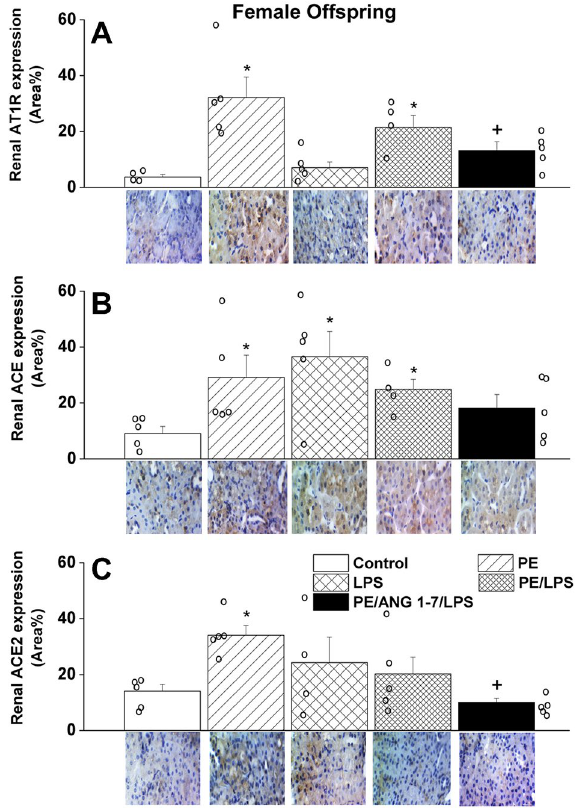
Figure 7. Effect of PE and /or LPS on immunohistochemical protein expression of AT1 receptors ( A ), ACE ( B ) and ACE2 ( C ) in renal tubular tissues of female offspring. The influence of prenatal administration